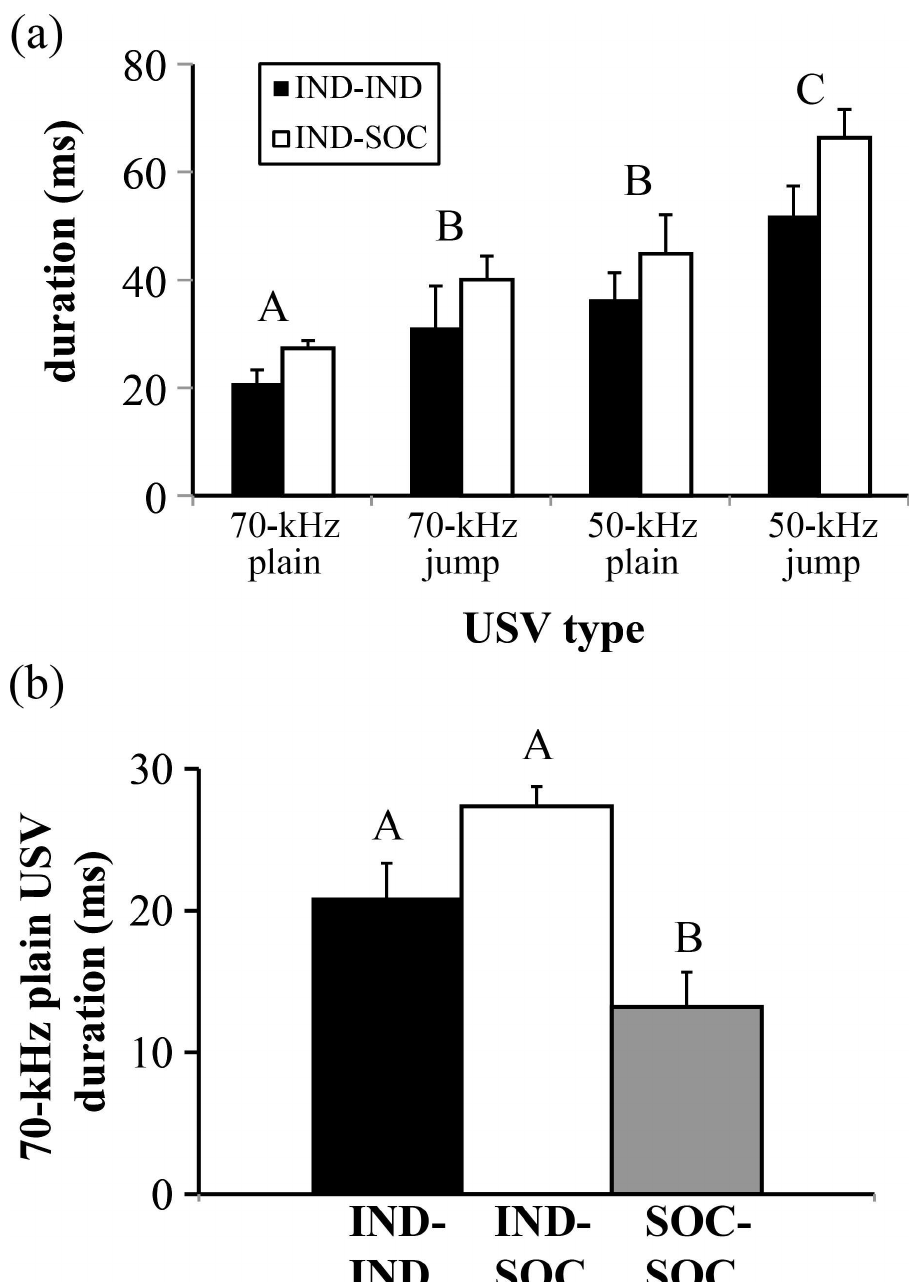
Fig 4. Mean durations of specific USV types emitted by pairs of male mice with different social histories. (a) Mean durationsof 70-kHz plain, 70-kHz jump, 50-kHz plain, and 50-kHz jump ultrasonic vocalizations (USVs) emitted by IND-IND and IND-SOC pairs of male mice. SOC-SOC pairs were not includedin this two-way analysis, becausefew SOC-SOC pairs emitted all four USV types. Bar heights representmeans ± S.E.M; bars with different letters indicatestatistical differences amongdifferent USV types (Bonferroni post-hoc tests, p < 0.05). There was also a main effect of pair type: IND-SOC pairs emitted longer durationUSVs than IND-IND pairs. (b) Mean durationof 70-kHz plain USVs emitted by pairs of male mice with different social histories. Bar heights represent means ± S.E.M; bars with different letters are statistically different (Bonferronipost-hoc tests, p < 0.05). IND = individuallyhoused male; SOC = sociallyhoused male. See methods for additional